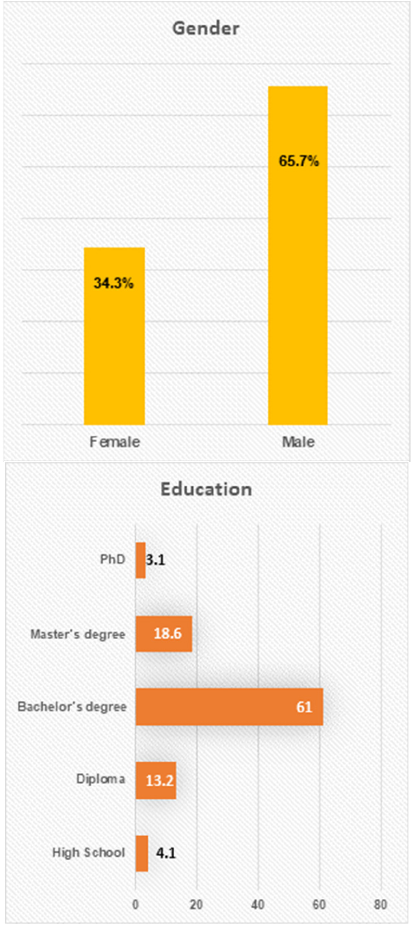
Figure 2. Descriptive analysis.